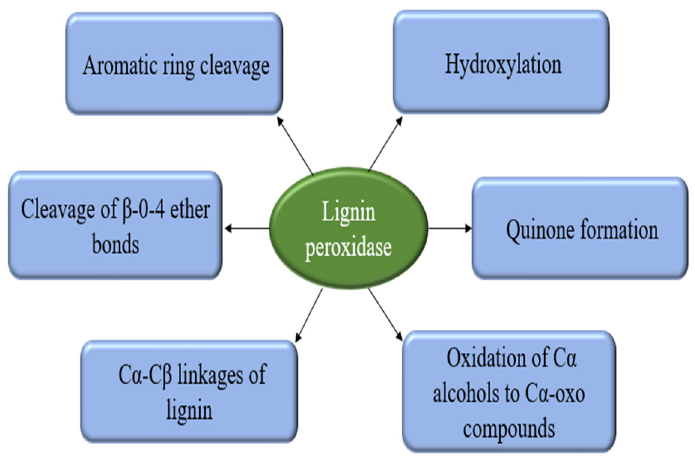
Figure 15. Different catalytic actions by LiP.